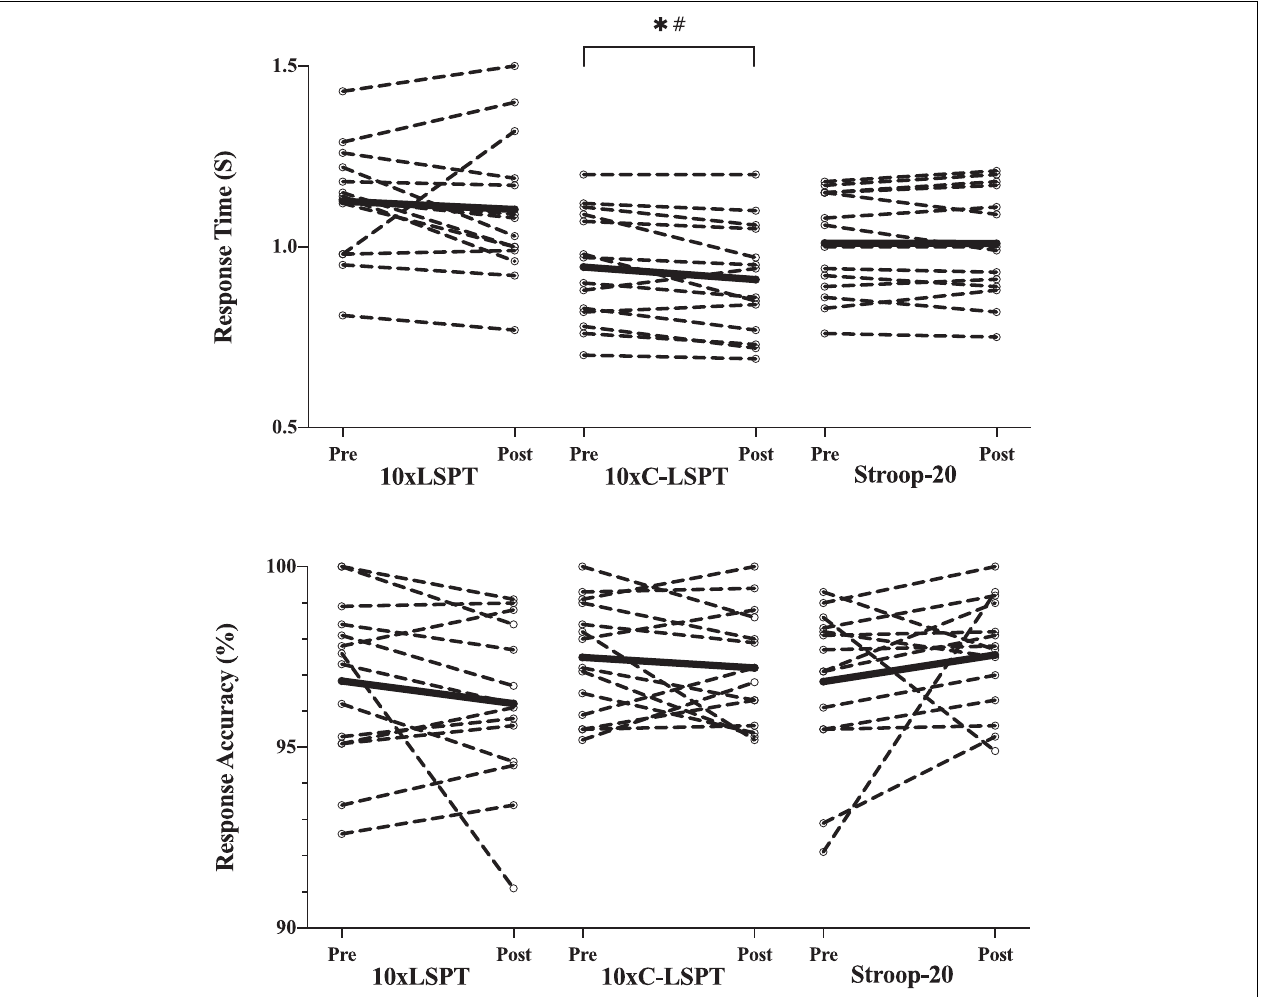
FIGURE 5 | Cognitive performance in pre- and posttests. The response time data of one player were excluded ( > 1.5 s). Circles and dashed lines indicate the data of individual participants, and black solid lines indicate the mean value. *Significant changes when compared with pretest ( p < 0.05); # moderate effect; 10xLSPT, repeated interval Loughborough Soccer Passing Test; 10xC-LSPT, repeated interval modified Loughborough Soccer Passing Test in clockwise order of pass direction; Stroop-20, 20-min Stroop